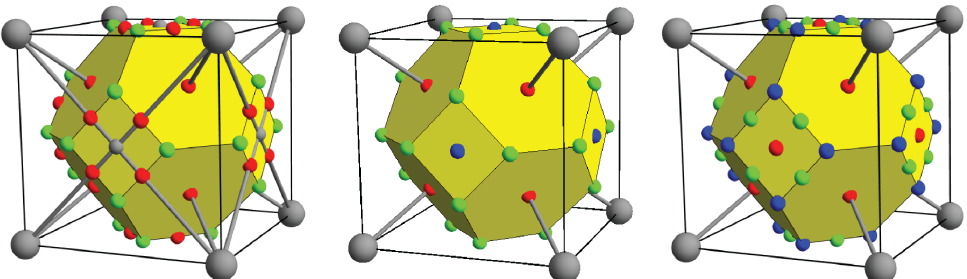
Figure 3. For clarity, all the critical points and bond paths of each topology may not be shown. From left to right, the topologies of the nonmagnetic early HCP, BCC, and late HCP and FCC metals forced the BCC crystallographic